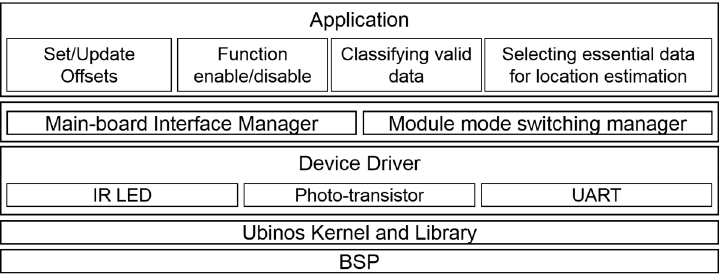
Figure 16. Software architecture of main board.